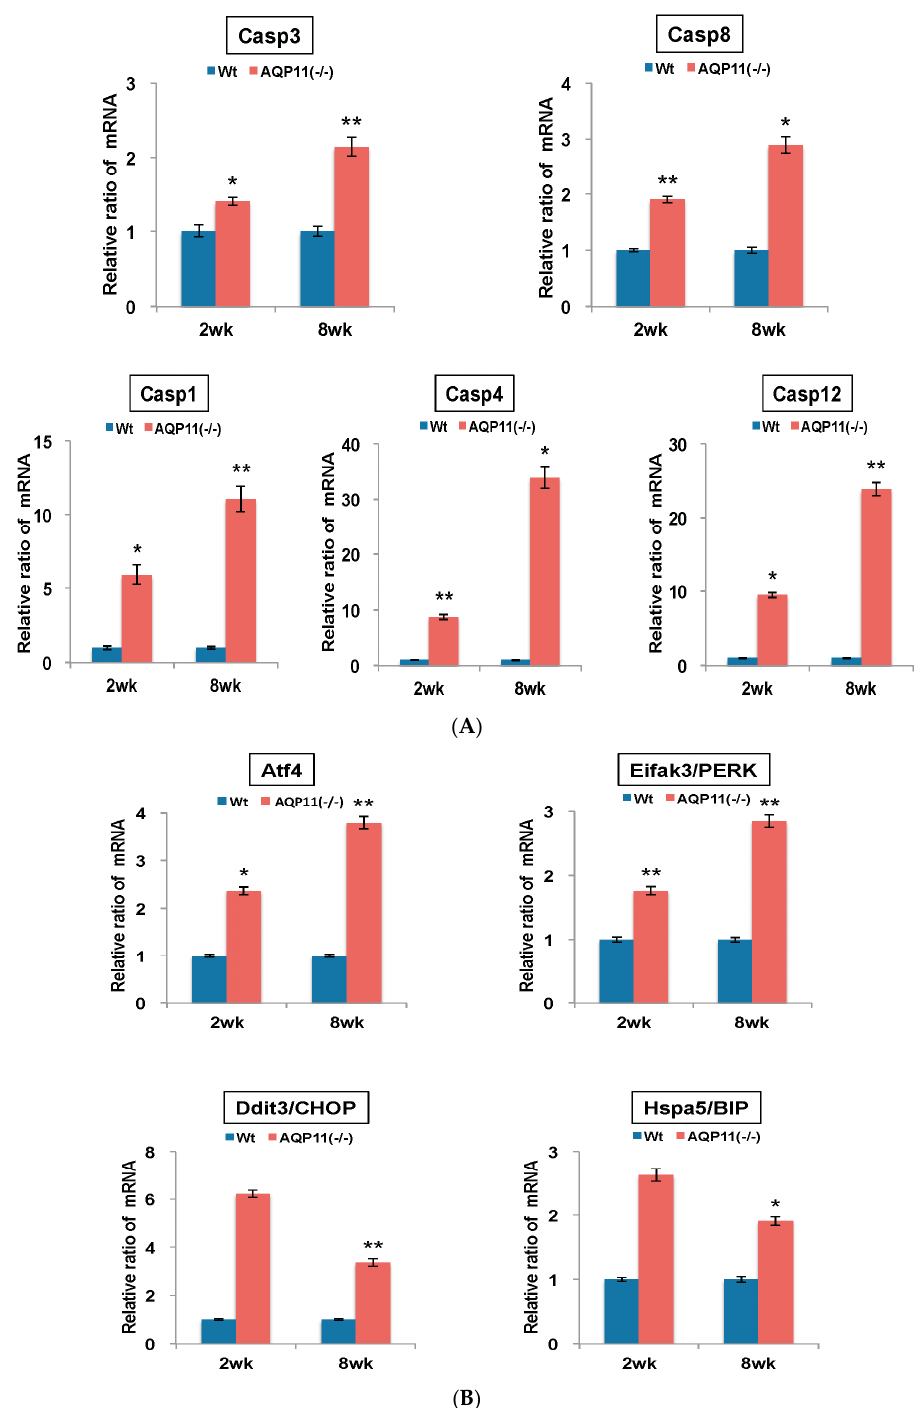
Figure 5. Quantitative analysis of mRNA expression in the kidney of AQP11( − / − ) and wild-type mice at two and eight weeks old. All genes were compared by qRT-PCR between AQP11( − / − ) mice and wild-type mice (Wt) at two weeks (wk) old and at eight weeks old. The expression levels in the age-matched wild-type kidney are arbitrarily normalized to one. ( A ) Expression of inflammation, apoptosis, and ER stress–related caspase family genes; ( B ) Expression of ER stress response genes related to Atf4/PERK signaling pathway. The results are shown by the mean +/ − SD. The number of experiments was three to four each week. * p < 0.005 and ** p < 0.025 as compared with wild type ( n = 4 to 5 per group at two weeks old, n = 3 per group at eight weeks old).